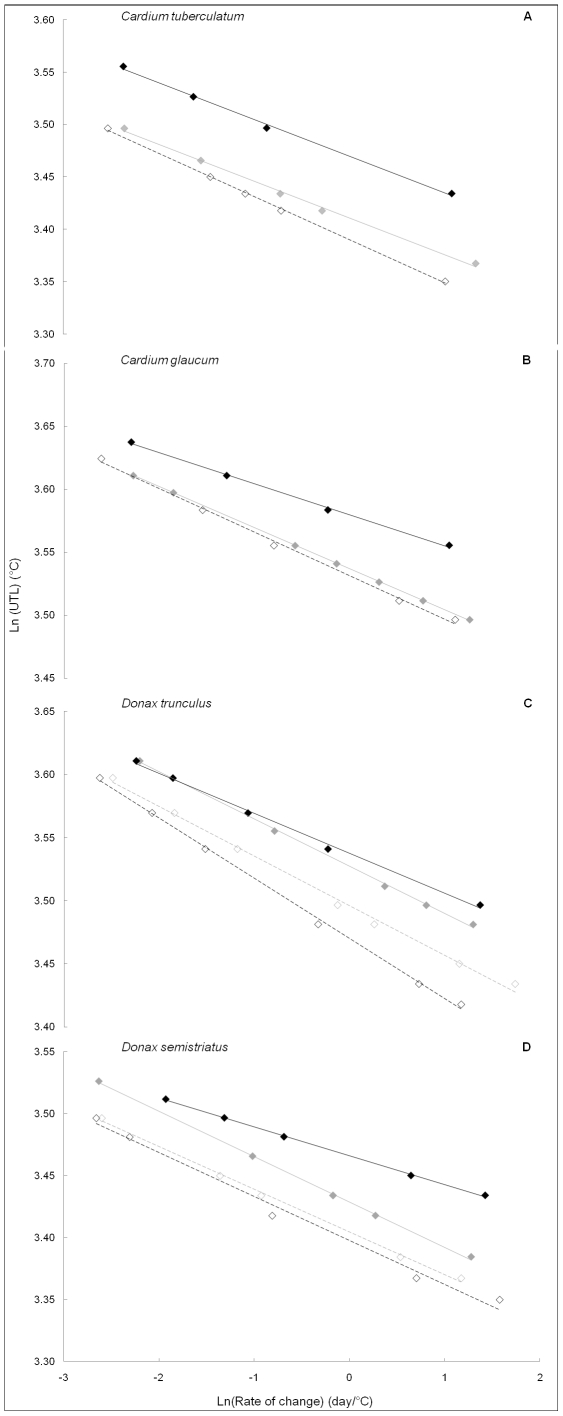
Log-log relationship for upper temperature limit (UTL) versus rate of temperature change.This is shown for four different species from the Mediterranean Sea in different seasons: A) Cardium tuberculatum, B) Cardium glaucum, C) Donax trunculus and D) Donax semistriatus. Black diamonds: summer, open black diamonds: winter, grey diamonds in a and b: autumn and spring, grey diamonds in c and d: autumn and open grey diamonds: spring. For each season and each species a linear regression is fitted. A) Black diamonds: y = −0.034×+3.5 R2 = 1, grey diamonds: y = −0.034×+3.4 R2 = 1, open black diamonds: y = −0.04×+3.4 R2 = 1; B) Black diamonds: y = −0.024×+3.6 R2 = 1, grey diamonds: y = −0.032×+3.5 R2 = 1, open black diamonds: y = −0.034×+3.5 R2 = 1; C) Black diamonds: y = −0.032×+3.5 R2 = 1, grey diamonds: y = −0.038×+3.5 R2 = 1, open grey diamonds: y = −0.039×+3.5 R2 = 1, open black diamonds: y = −0.048×+3.5 R2 = 1; D) Black diamonds: y = −0.023×+3.5 R2 = 1, grey diamonds: y = −0.037×+3.4 R2 = 1, open grey diamonds: y = −0.034×+3.4 R2 = 1, open black diamonds: y = −0.035×+3.4 R2 = 0.99.